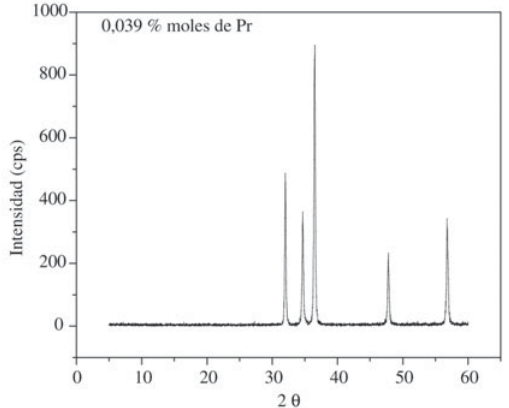
Figura 4. Difractograma de rayos x de una muestra que contiene 0,039 % en moles de Pr sinterizada a 1300 °C durante 2 h.